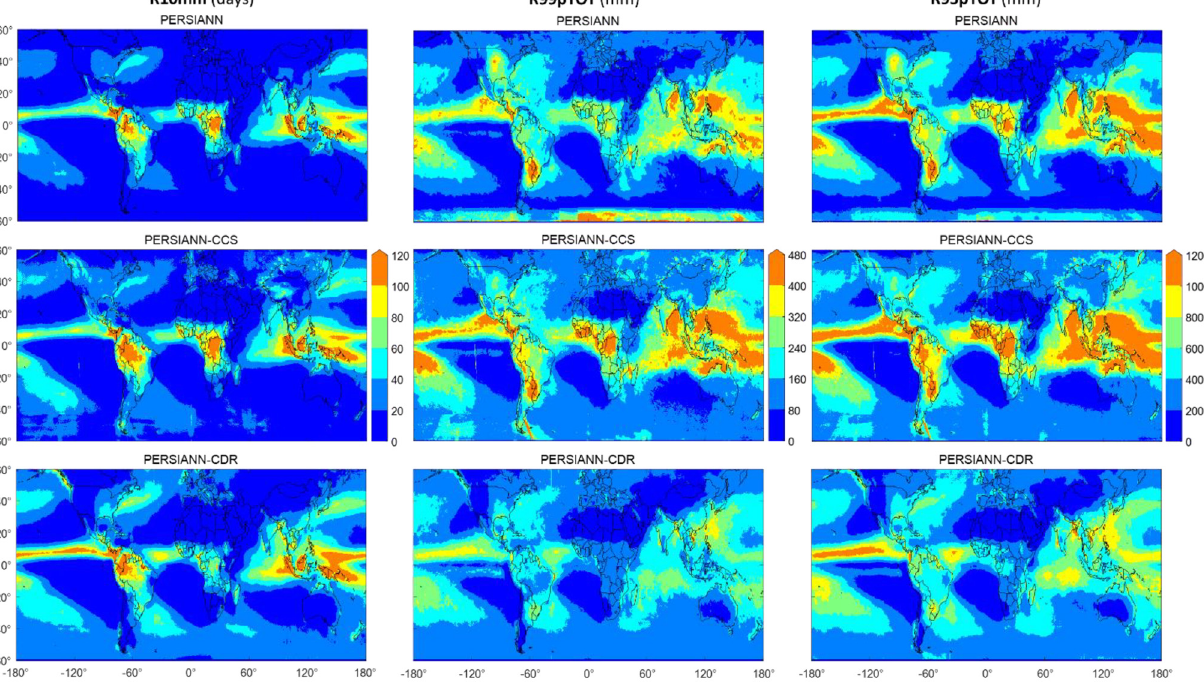
Figure 11. Extreme precipitation indices (R10mm, R99pTOT, and R95pTOT) for PERSIANN, PERSIANN-CCS, and PERSIANN-CDR over the globe. (See Table 4 for definitions of the